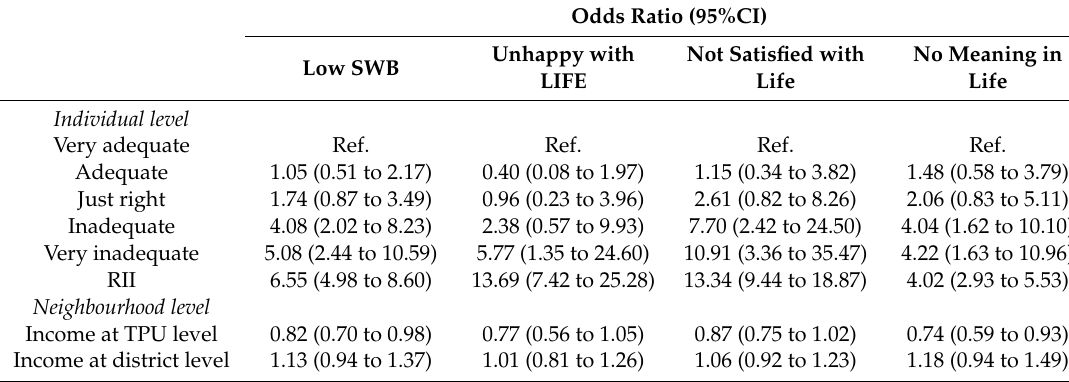
Table 2. Multilevel associations of income and components of and overall subjective well-being.